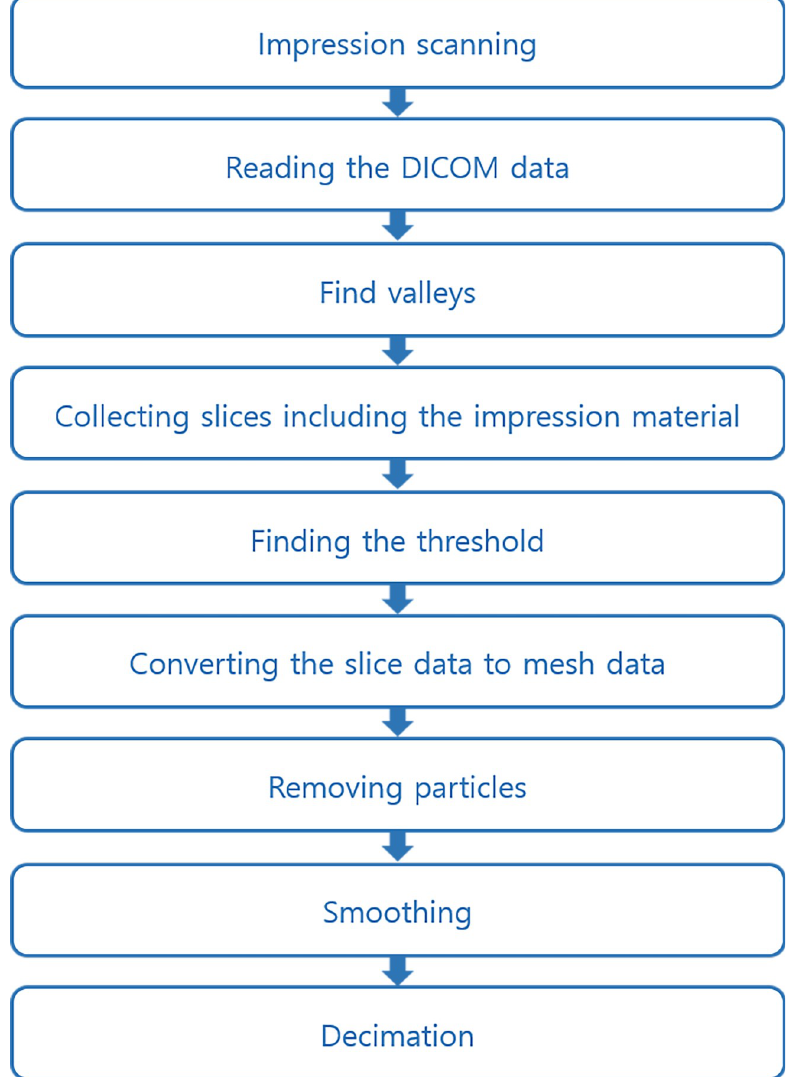
Fig 4. Flow chart of the conversion